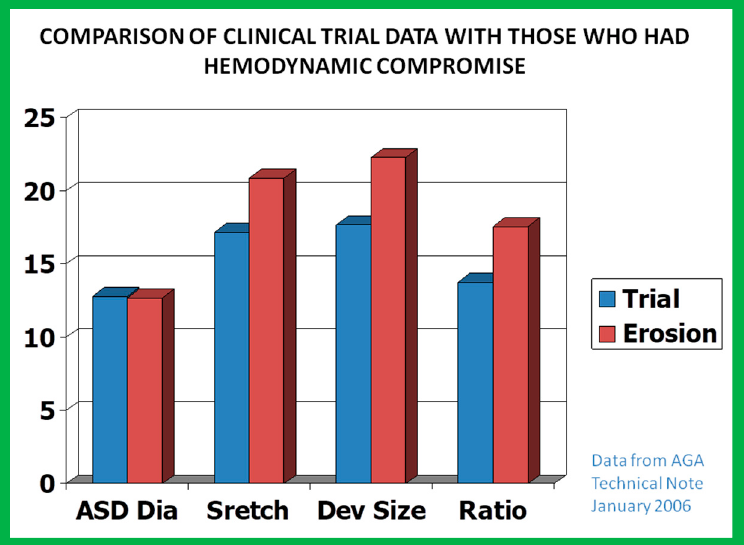
Figure 47. The relation between the diameters of atrial defects and sizes of the Amplatzer device among patients who showed no evidence of perforation (Trial), and those with perforation (Erosion) are shown in this bar diagram. The diameter (Dia) of the atrial septal defect (ASD) was identical in both the described groups (left most panel). However, the balloon-stretched diameter (Stretch), diameter of the device (Dev size), and the ratio of device to atrial defect (Ratio) were larger (2nd, 3rd, and 4th panels) in patients who had perforation than those who did not have perforation (graph was created from the data published in References [71,72]). Based on this information, it was suggested that Amplatzer devices no bigger than 1.5 × the atrial defect diameter should be utilized. Replicated from Reference [51].